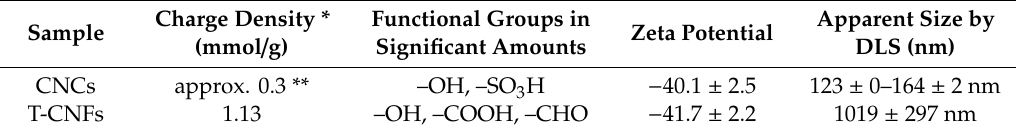
Table 3. Charge density and properties of the nanocellulose qualities. Sample